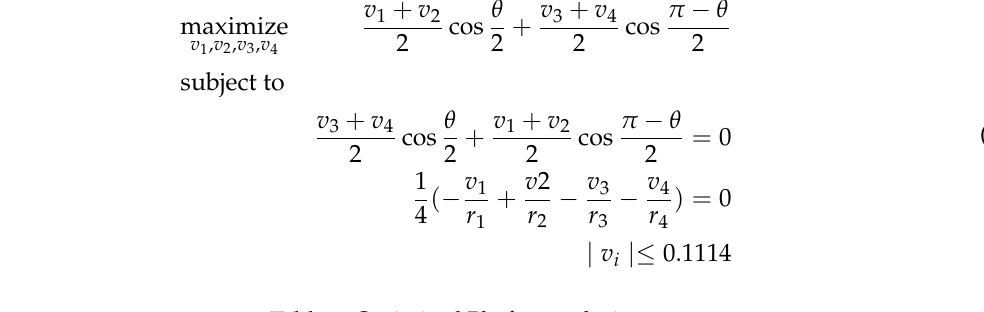
Table 1. Optimized Platform